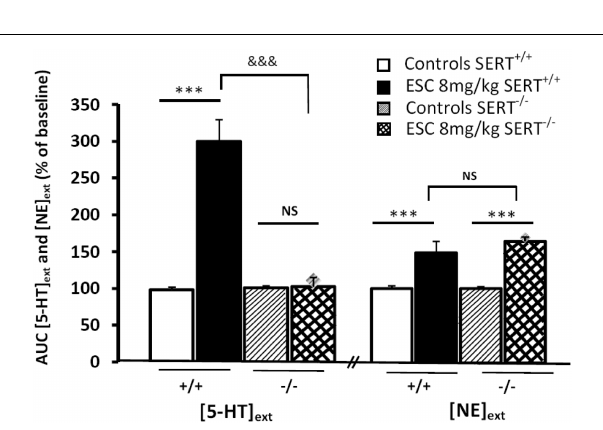
FIGURE 3 | (A) Microdialysis data showing the effects of paroxetine on cortical 5-HText in 5-HT 1A + / + wild-type and 5-HT 1A − / − mice. Results are expressed as AUC values (means ± SEM) calculated for the amount of 5-HText collected during the 0–60 min post-treatment period. (B) Antidepressant-like effects of paroxetine on the immobility time in the mouse forced swimming test (FST) in 5-HT 1A + / + and 5-HT 1A − / − mice. FST and microdialysis experiments have been performed separately. Microdialysis and behavioral experiments were carried out by using the same experimental protocol.The duration time of the FST was 6 min, performed at the maximum